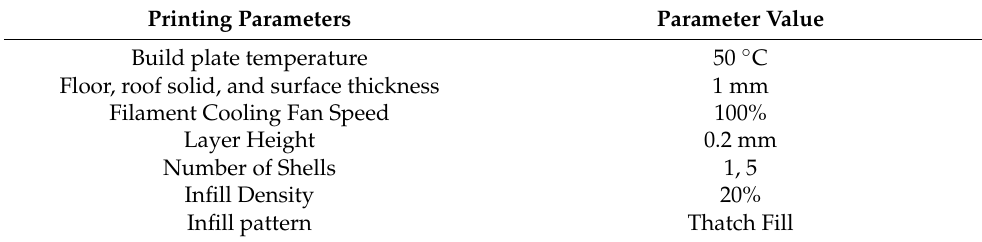
Table 1. Optimized parameters for 3D printing of drug-loaded